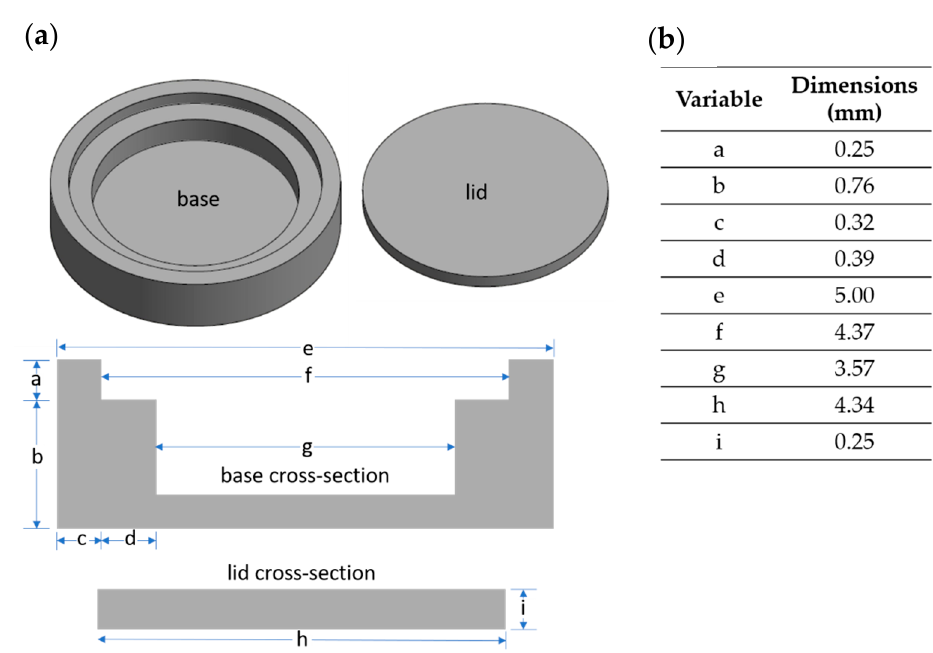
Figure 2. New AM melt wire encapsulation. ( a ) A schematic of the new encapsulation design with base and lid cross-section shown, and ( b ) dimensions of the base and lid.